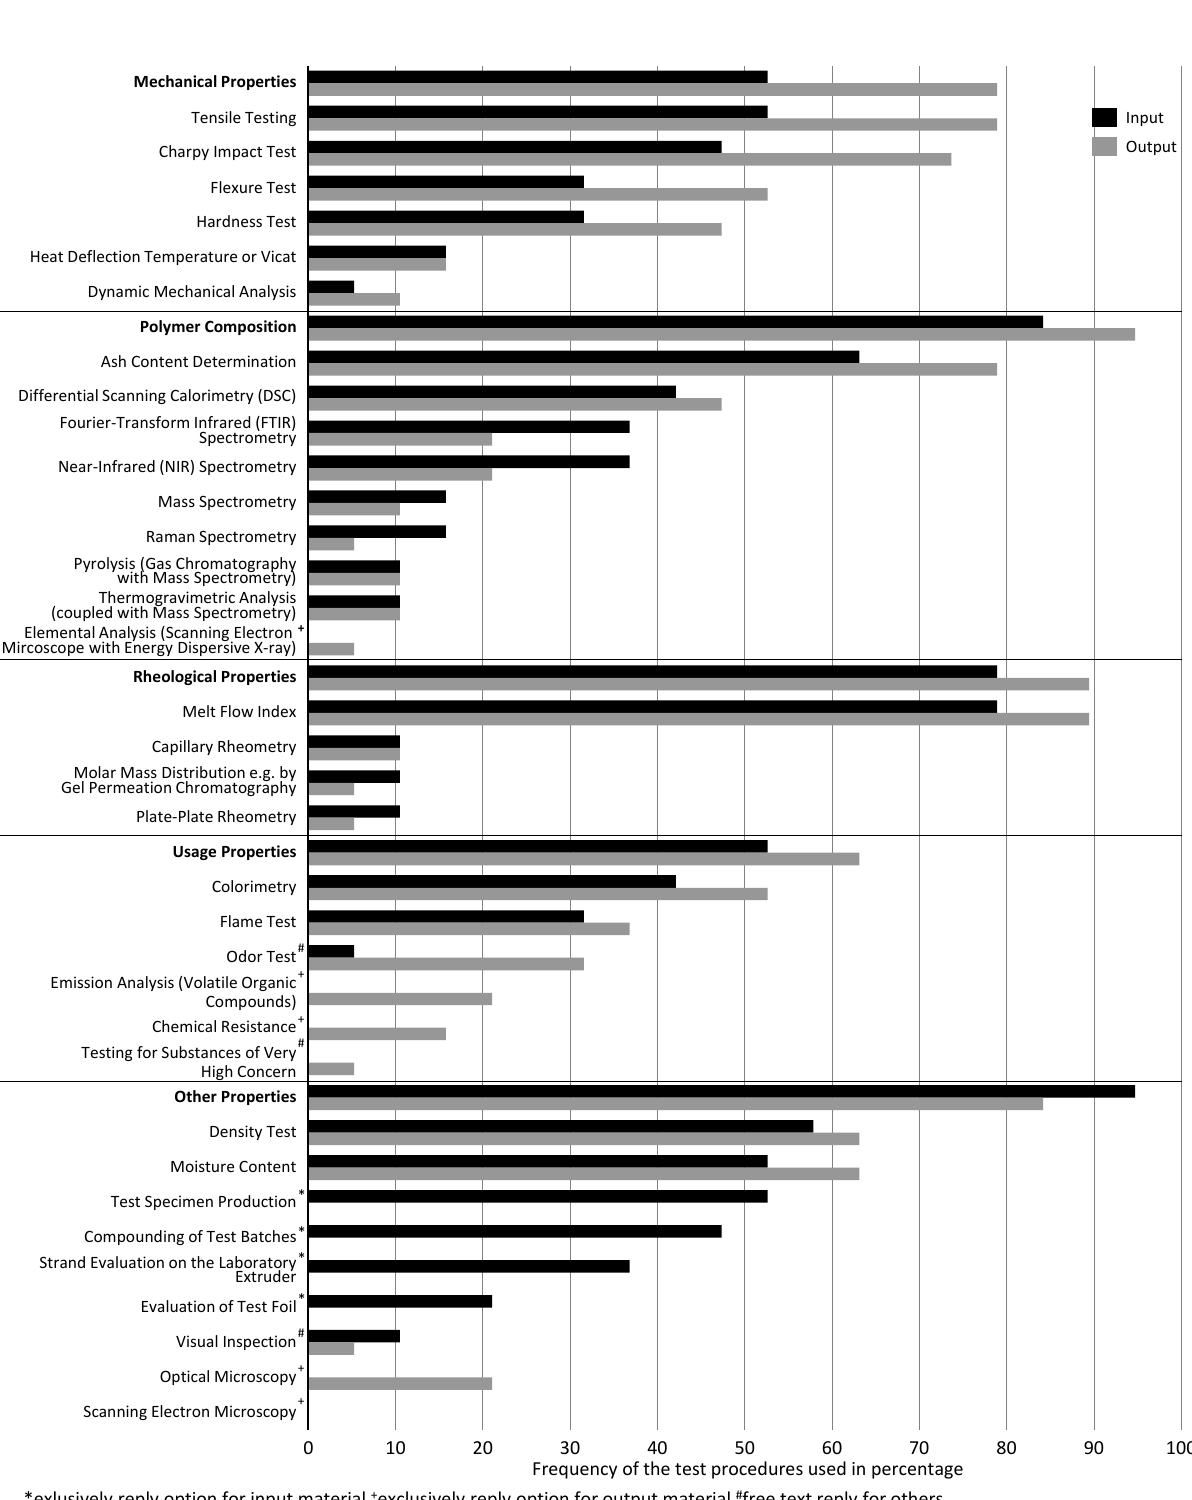
Figure 4. Quality assurance measures on input and output materials